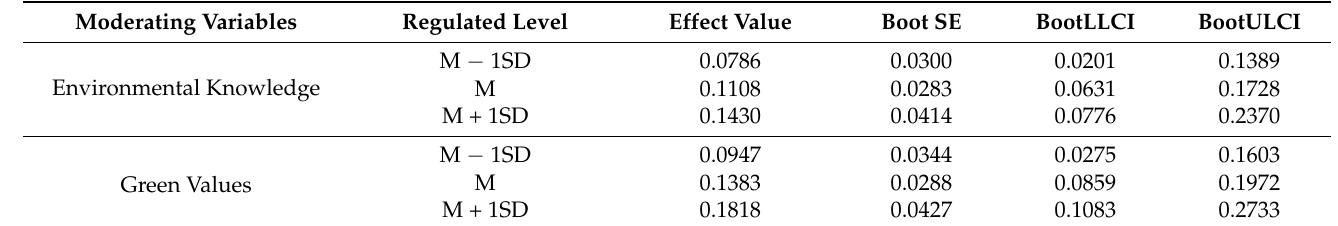
Table 6. Intermediary effect of the relational psychological contract under different adjustment levels of environmental knowledge and green